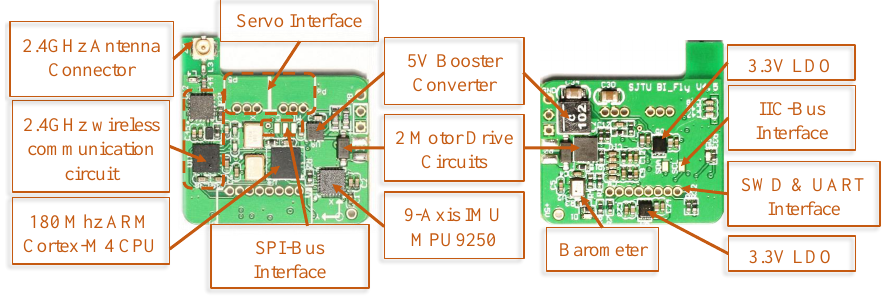
Figure 2. Illustration of the main autopilot